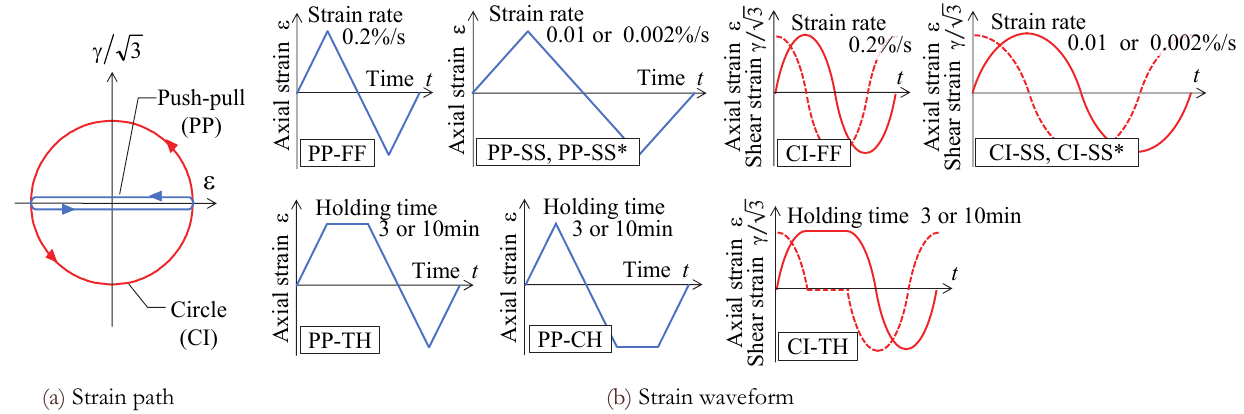
Figure 2: Strain path and strain